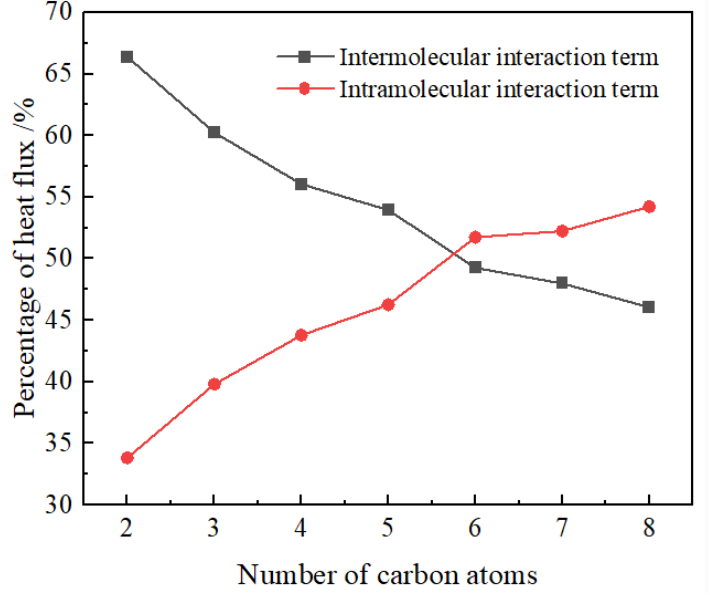
Figure 9. Ratios of intermolecular and intramolecular energy transfer to interaction term for seven species of alcohol at 323.15 K.